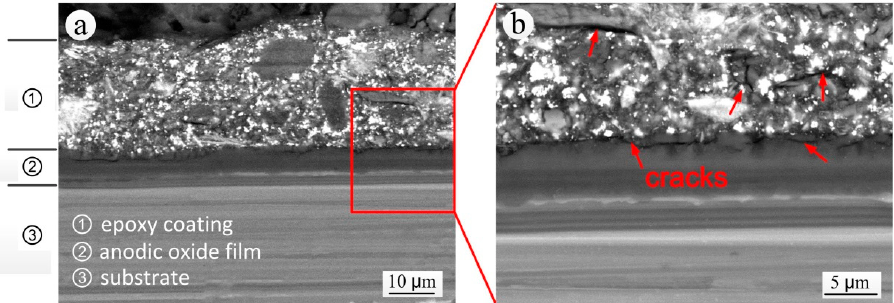
Figure 10. Backscattered electron image of the S-L section of the specimen exposed for 20 years: ( a ) SEM morphology; ( b ) local enlarged SEM morphology.